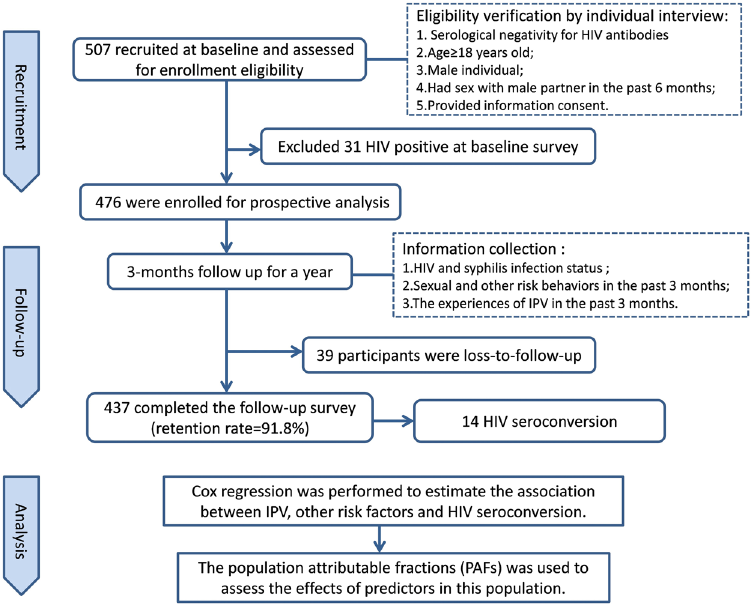
Figure 1. Participation of eligible men who have sex with men in the open cohort study in Shenyang,